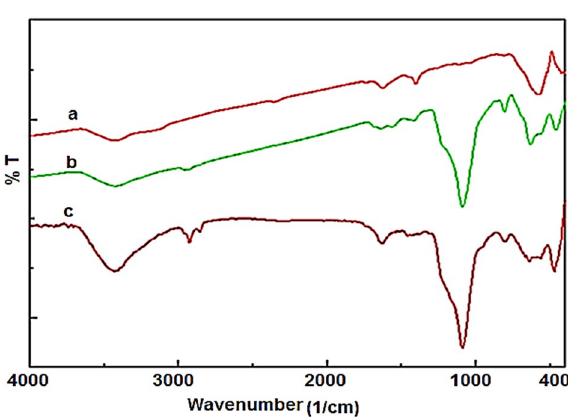
Figure 2. FT-IR spectra of ( a ) Fe 3 O 4 , ( b ) Fe 3 O 4 @SiO 2 and ( c ) Fe 3 O 4 @SiO 2 @IL-PMO/Pd